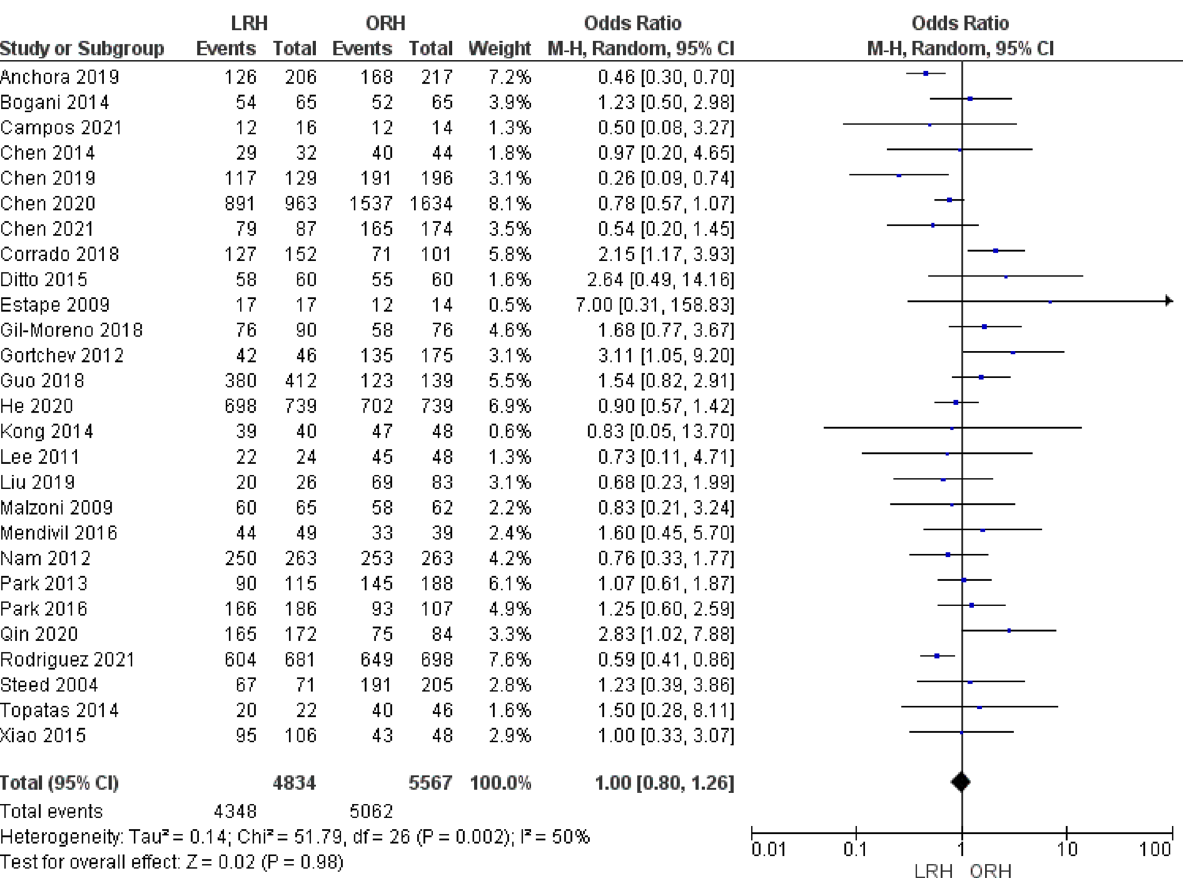
Figure 9. Forest plot of the rate of disease free